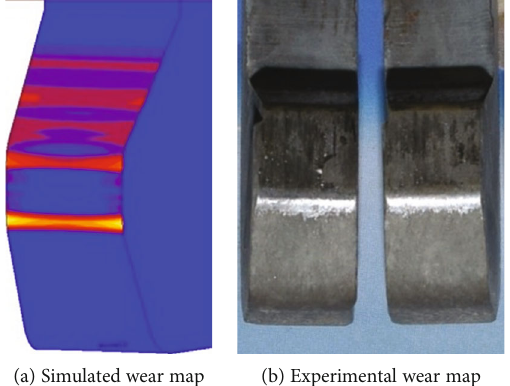
Figure 21: Comparison of wear between the simulated surface and experimental surface of